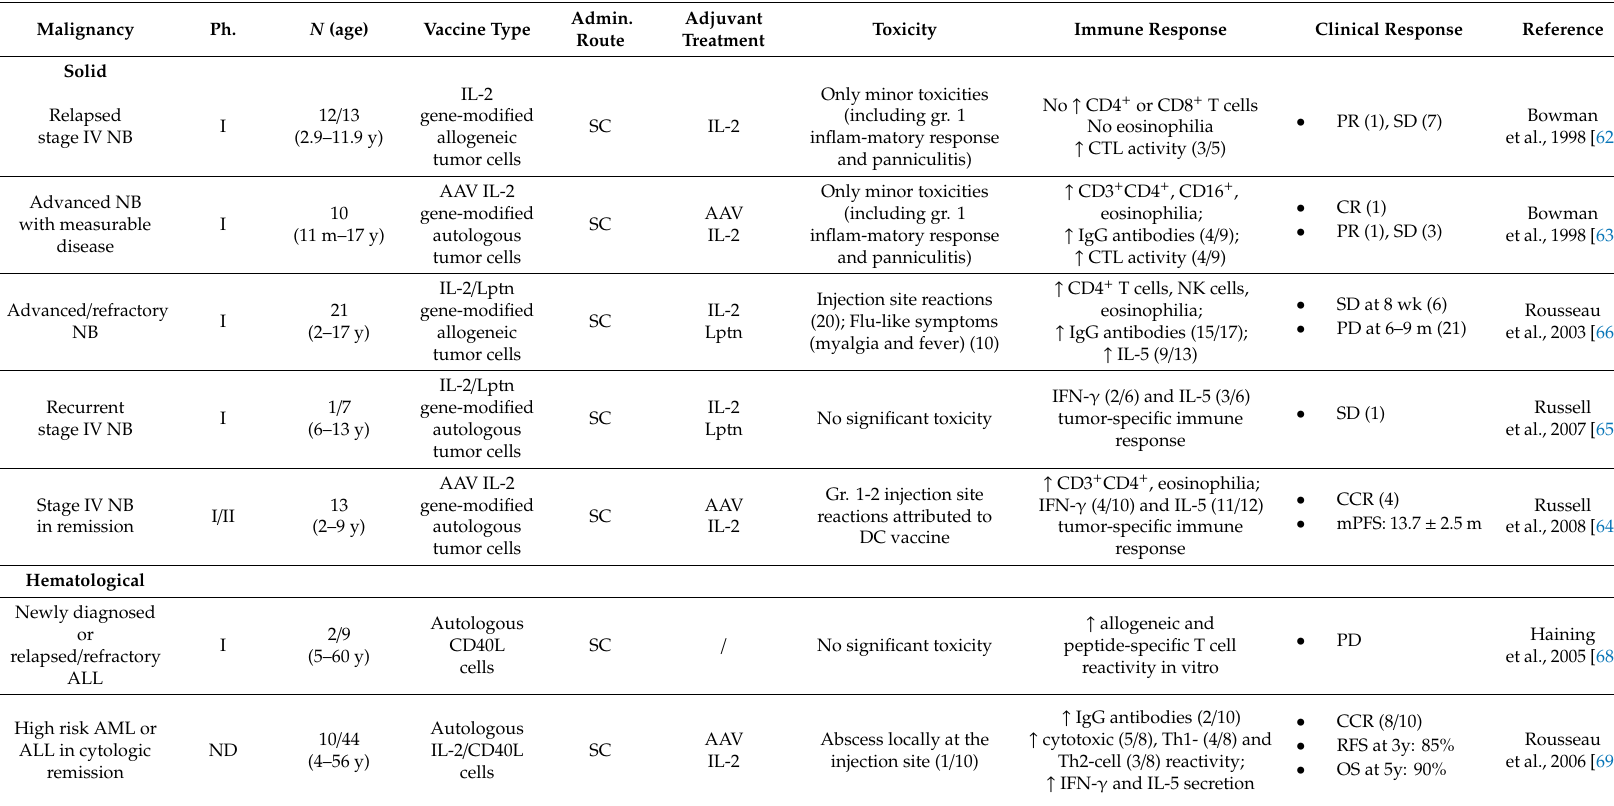
Table 2. Published tumor cell vaccination studies involving pediatric cancer